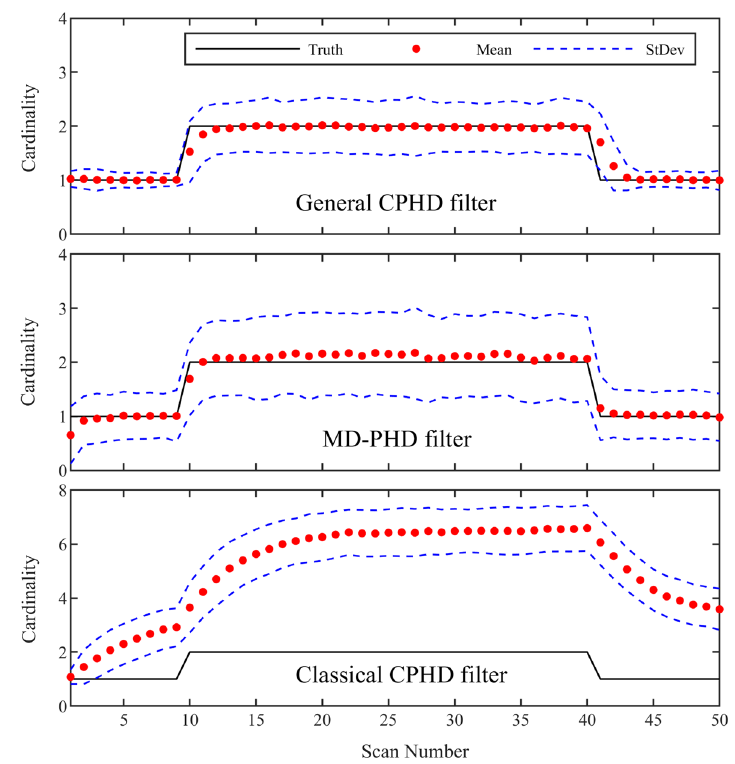
Fig. 7 Average of cardinality for scenario